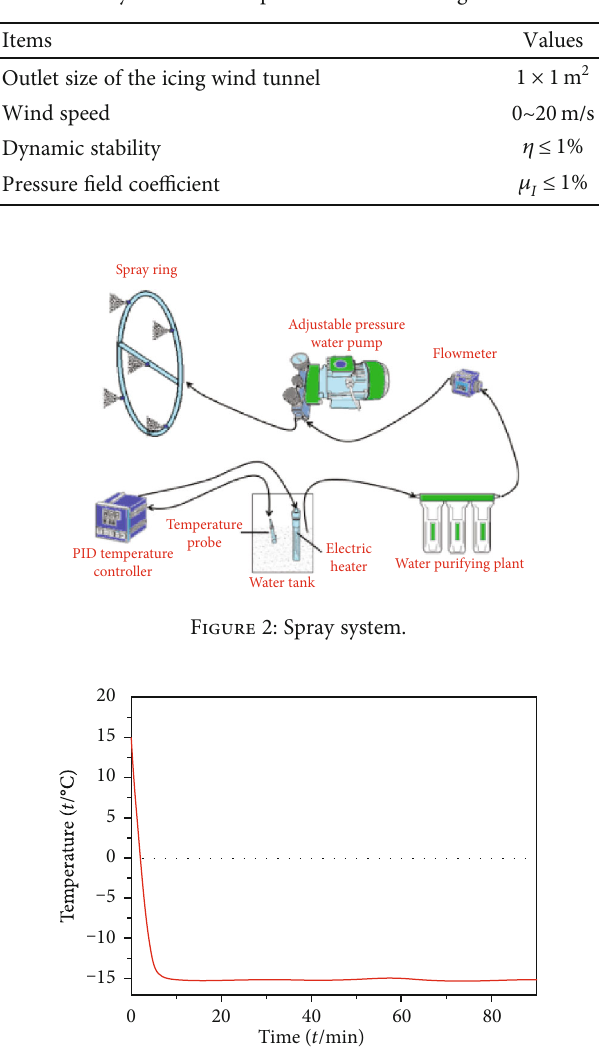
Figure 3: Variation of temperature in 90